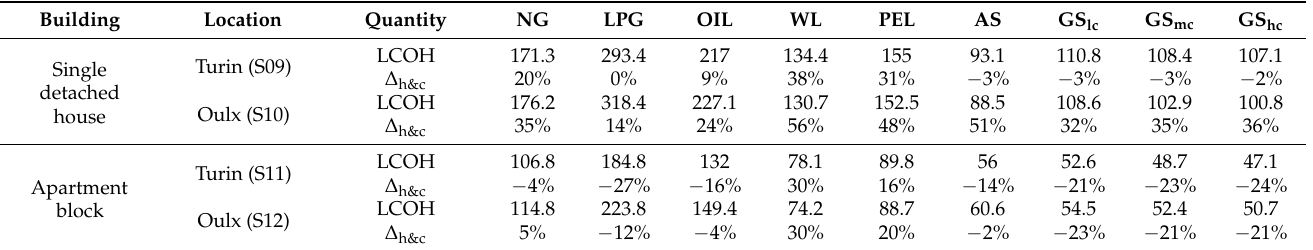
Table 7. LCOH values (EUR/MWh) with incentives referred to heating and cooling solutions and the relative variation compared to the heating-only case ( ∆ h&c ). Legend: NG = natural gas condensing boiler, LPG = LPG condensing boiler, OIL = diesel oil condensing boiler, WL = wood logs boiler, PEL = pellet boiler, AS = air-source heat pump, GS = geothermal heat pump (subscripts stand for low, medium, and high conductivity,